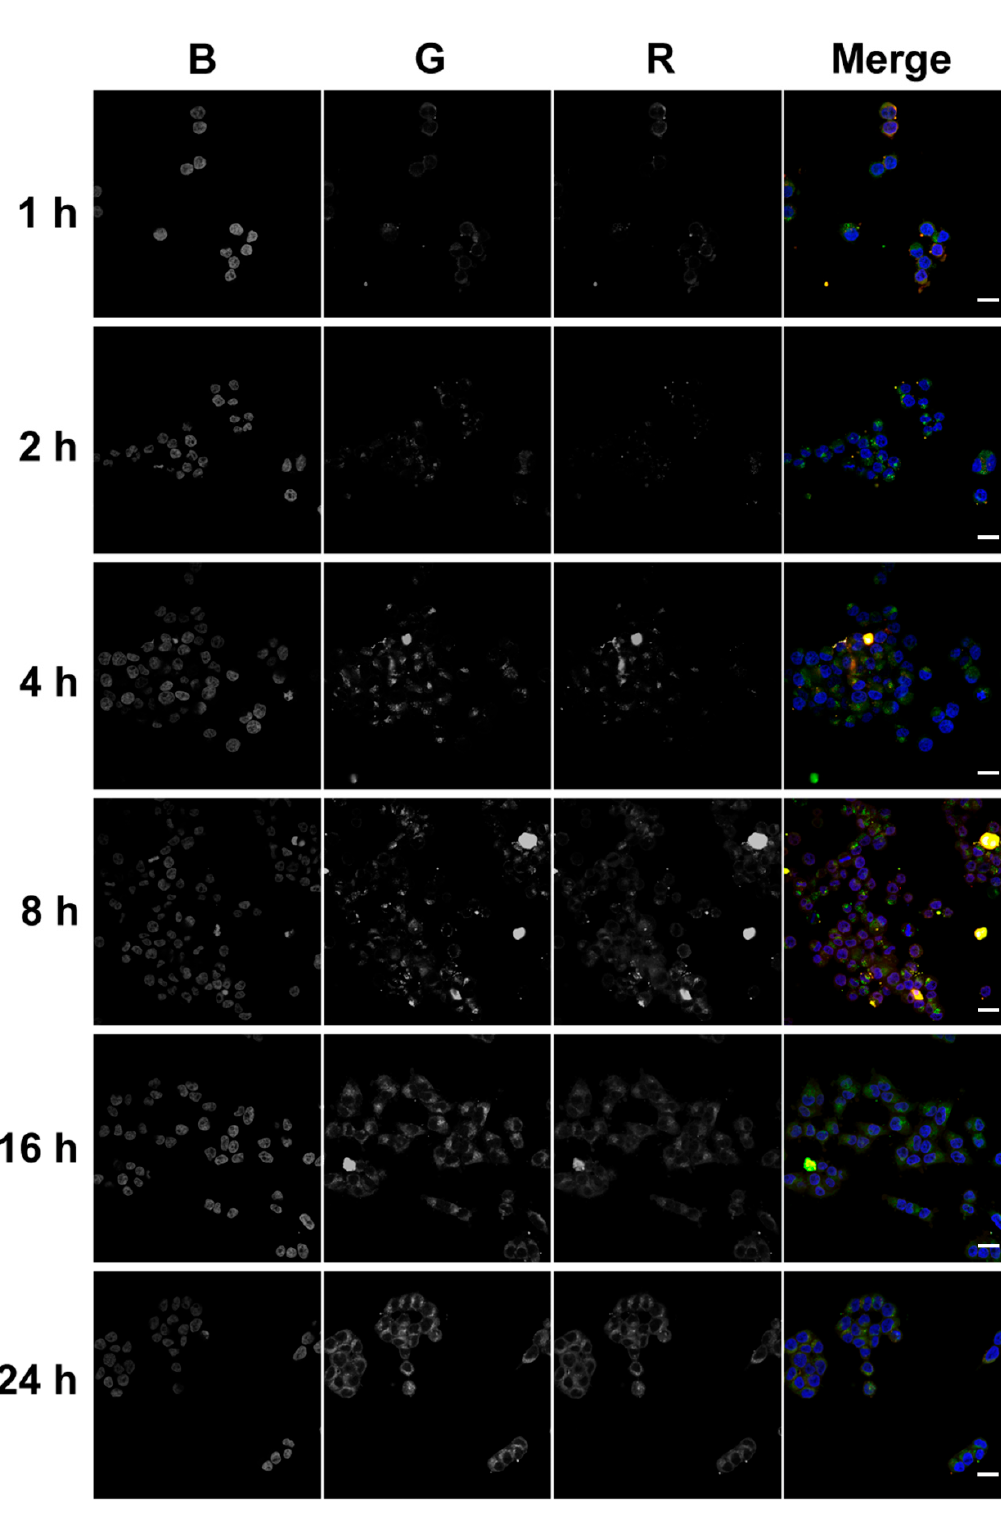
Figure 9. Accumulation of duplex TD2/ON-PO in KB-8-5 cells. Analysis of samples was performed 1, 2, 4, 8, 16 and 24 h after addition of duplexes (1 µM) to the cells. Duplexes consisted of FAM-labeled TD2 and By5.5-labeled ON-PO. Analysis was performed with confocal fluorescent microscopy by using a plan-apochromat 63×/1.40 Oil DIC M27 objective. Three-channel (BGR) pictures were obtained using staining by DAPI (nuclei staining) ( B ); FAM ( G ), attached to TD2, and By5.5 ( R ), attached to ON-PO. Scale bars: 20 µm.